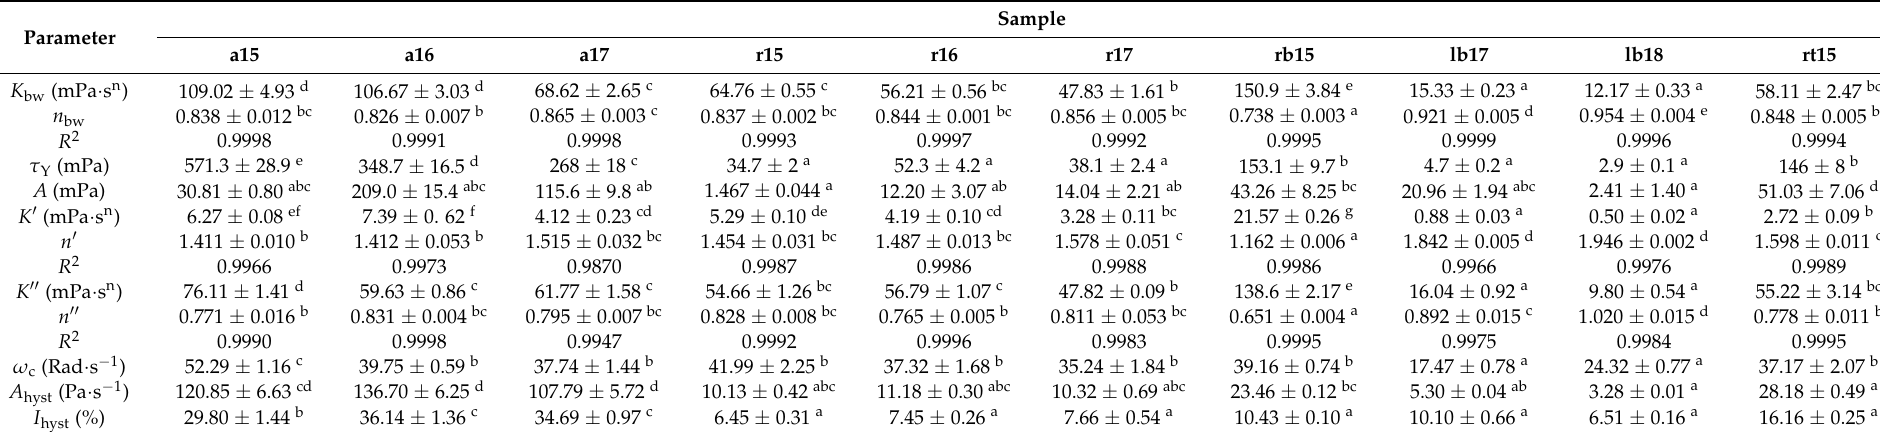
Table 5. Rheological parameters measured for FSM samples from various flax cultivars (mean ± SD, N =